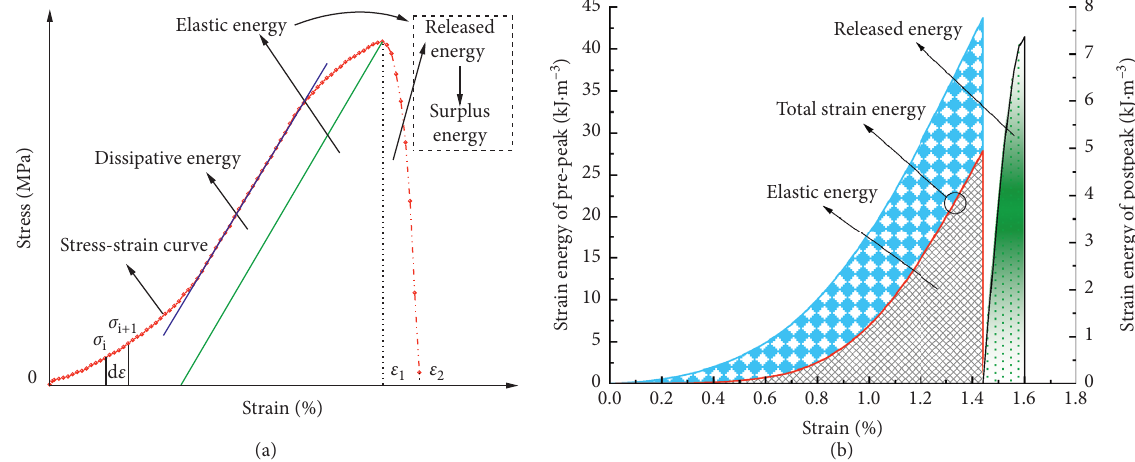
Figure 4: The energy conversion process of typical intact rock specimens: (a) strain energy calculation principle and (b) strain energy